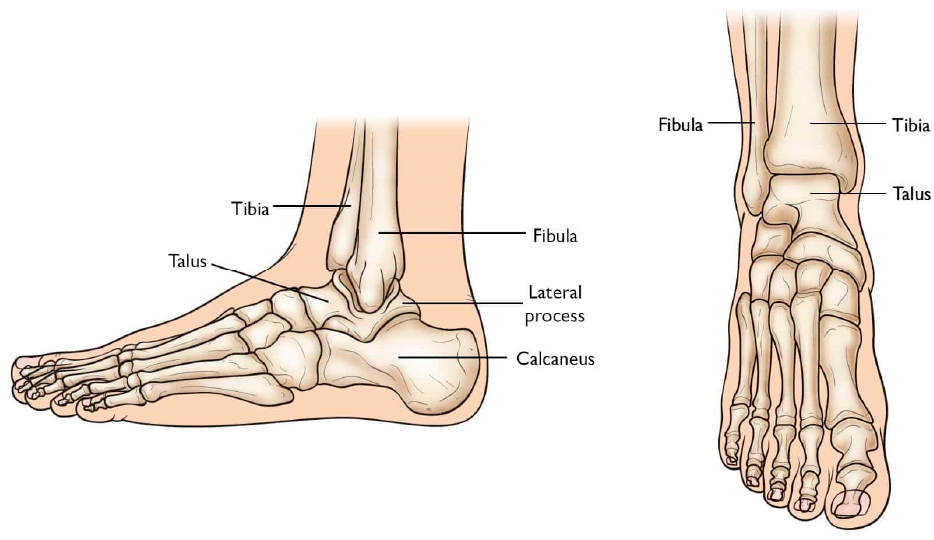
Figure 1. Simple schematic of the ankle joint.